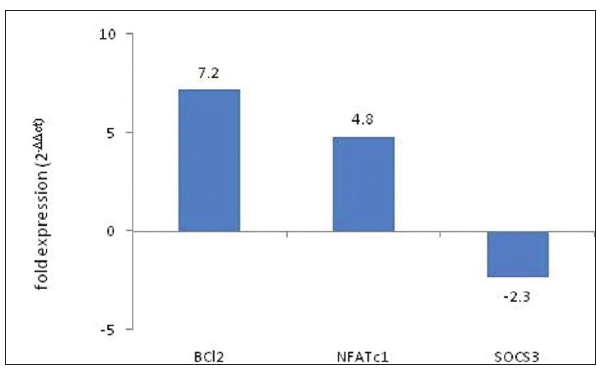
Figure-4: Biological activity study of bovine interleukin 7 mature (bIL-7 mat) protein in bovine peripheral blood mononuclear cells by quantitative polymerase chain reaction. Approximately 2 × 10 6 cells were incubated with 100 ng of bIL-7 matprotein for 3 h. Copies of different mRNA molecules were quantified by real time polymerase chain reaction. B-cell lymphoma 2 and nuclear factor for activated T-cells c1 molecules show 7.2- and 4.8-fold increase while suppressor of cytokine signaling 3 molecules 2.3-fold decrease in the treatment group when compared with control group.